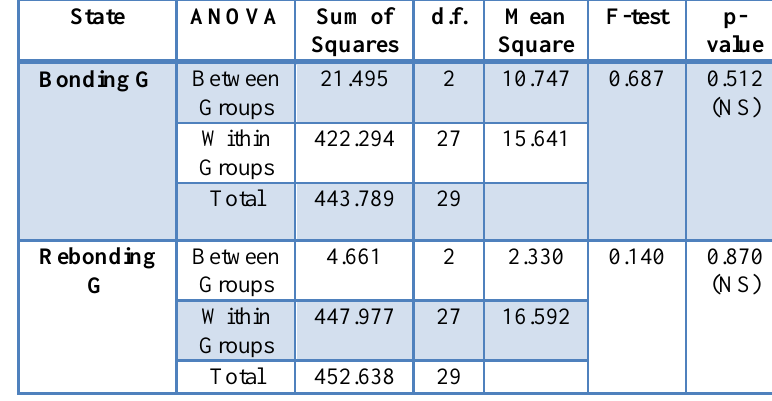
Table 2: Comparison of the shear bond strength in the bonding and rebonding groups.